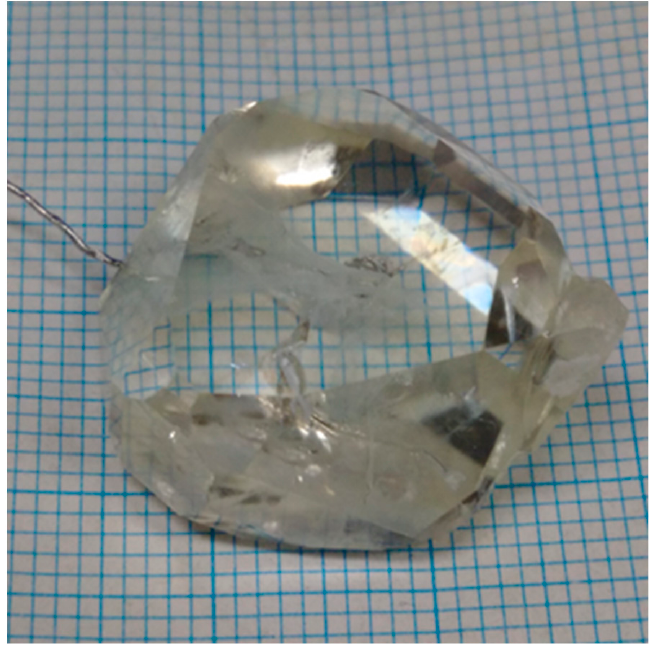
Figure 2. The Yb:YMgB 5 O 10 single crystal grown in a 20 wt.% Yb: YMBO–80 wt.% K 2 Mo 3 O 10 system (1 mm scale).